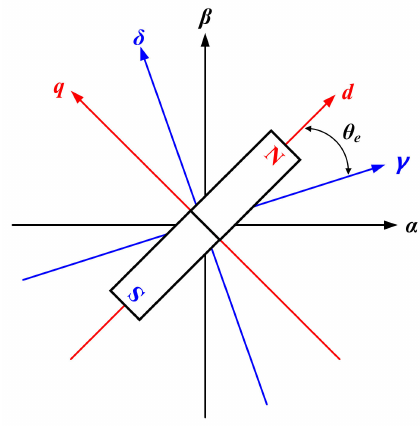
Figure 1. Reference frames for IPMSM